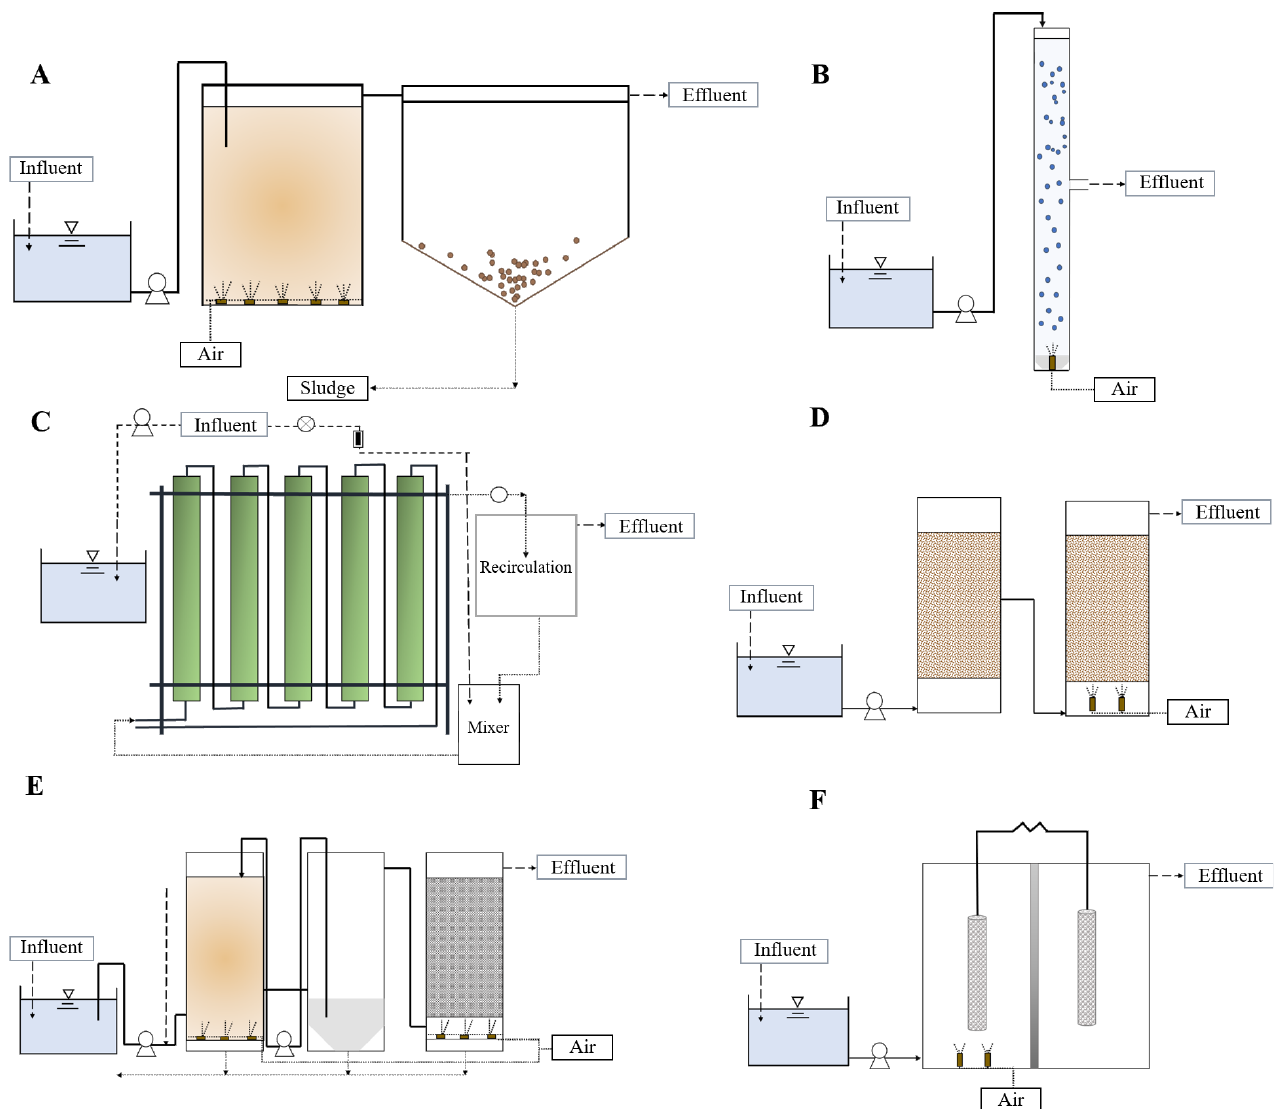
Figure 2. Diagram of biological water technologies for removing phenolic compounds from water: conventional activated sludge ( A ); aerobic granular sludge ( B ); photobioreactor ( C ); biofilter ( D ); membrane bioreactor ( E ); microbial fuel cell ( F ).